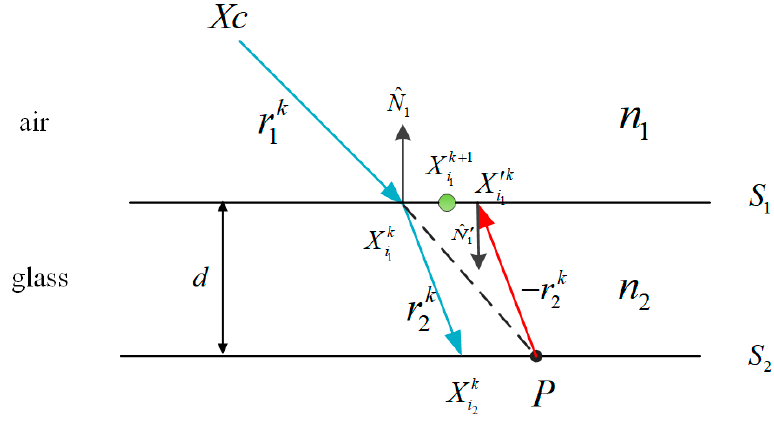
Figure 4. Schematic of ray tracing method.